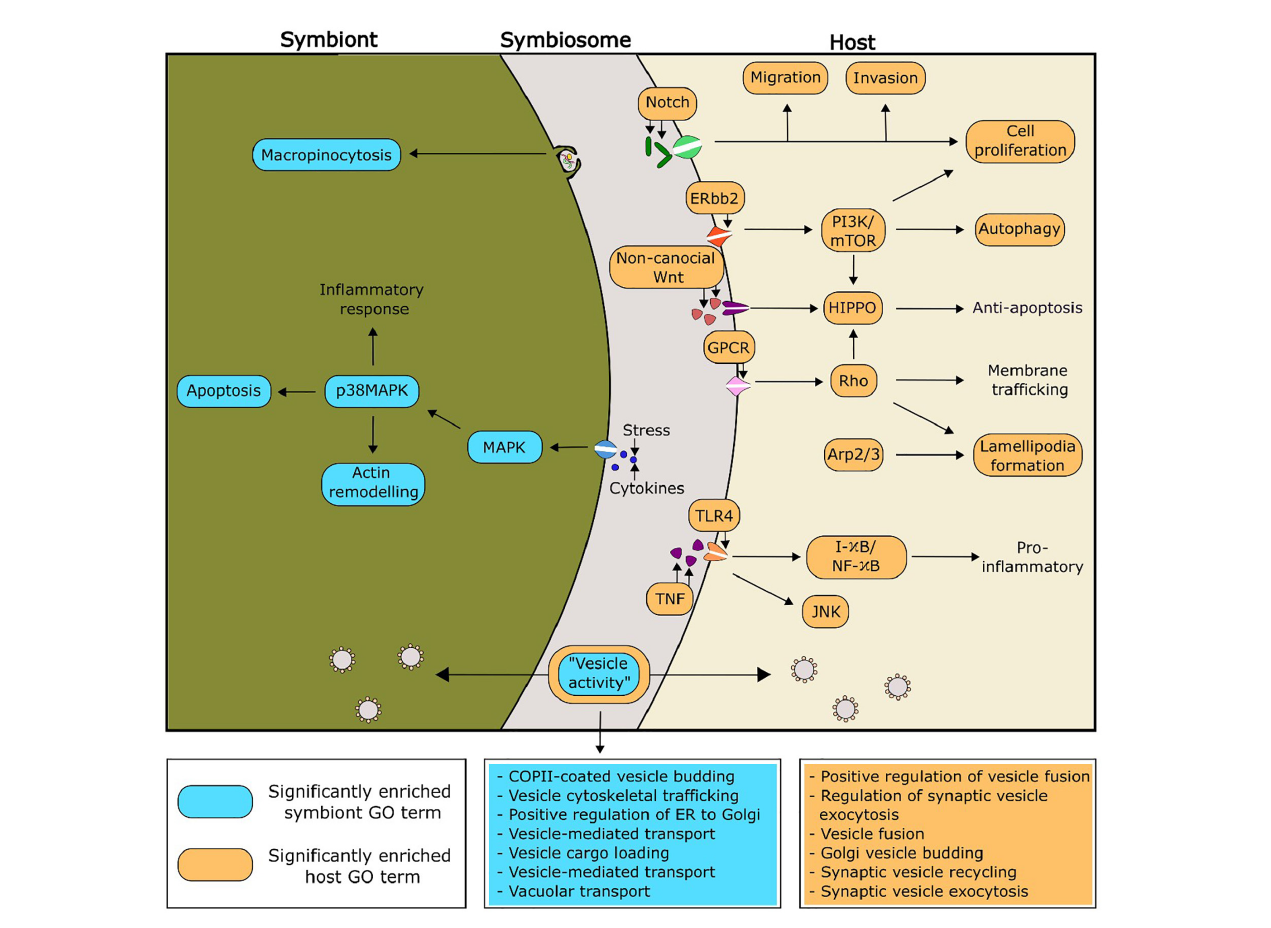
FIGURE4 Proposed functionality within the symbiosis of selected significantly enriched functions of the PIP-binding proteins, based on enriched GO functions within the model cnidarian, Aiptasia (orange), and Breviolum minutum (blue). The GO terms related to vesicle activity have been expanded in the two boxes coloured blue and orange, for symbiont and host,